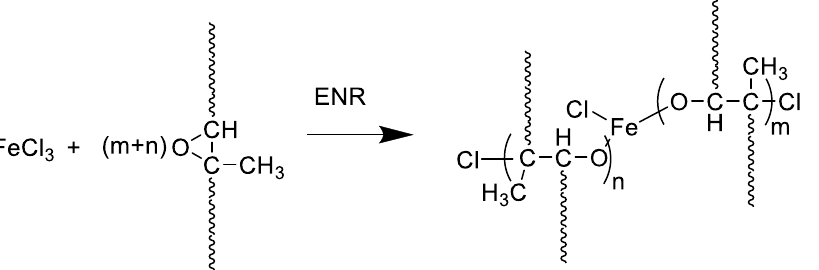
Figure 4. A proposed reaction mechanism between epoxidized natural rubber and ferric chloride. In the mechanism, the ring opening type polymerization of the epoxy group is described, which can be correlated with “internal polymerization” of the epoxy group of epoxide natural